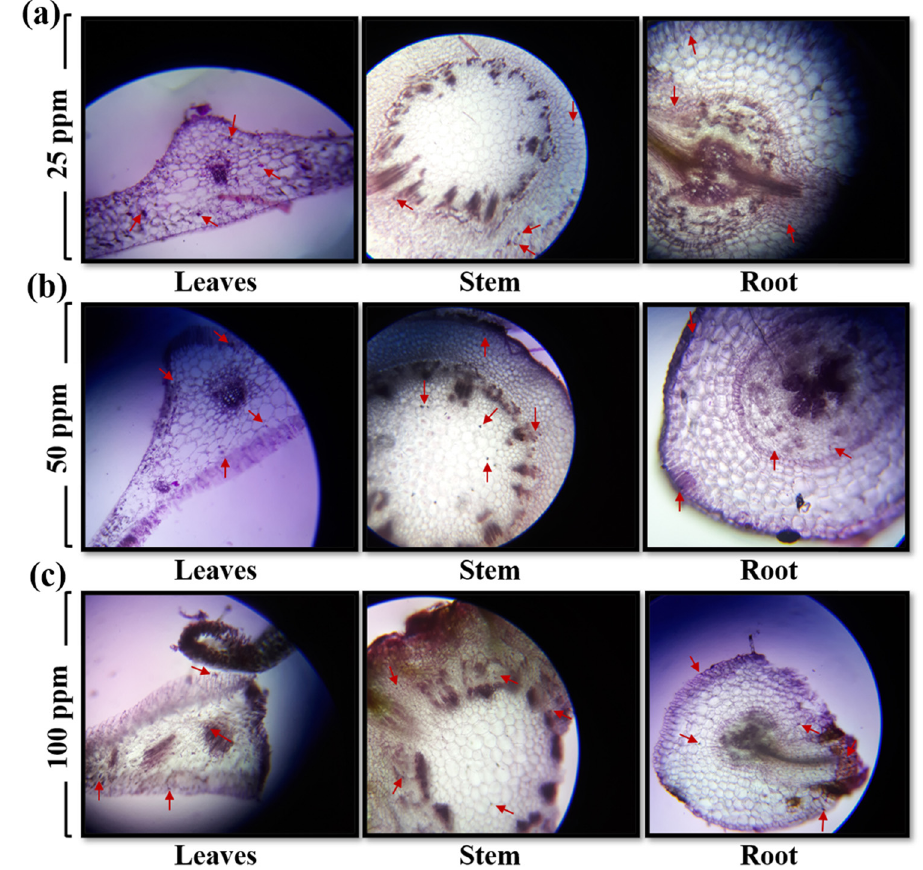
Figure 4: Morpho - anatomical analysis of L. sativa leaves, stem, and root: ( a ) 25 ppm, ( b ) 50 ppm, and ( c ) 100 ppm. The images were recorded under a light microscope ( Nikon 104, Japan ) at a resolution of 1,500 × with the help of a 20 mega pixel digital